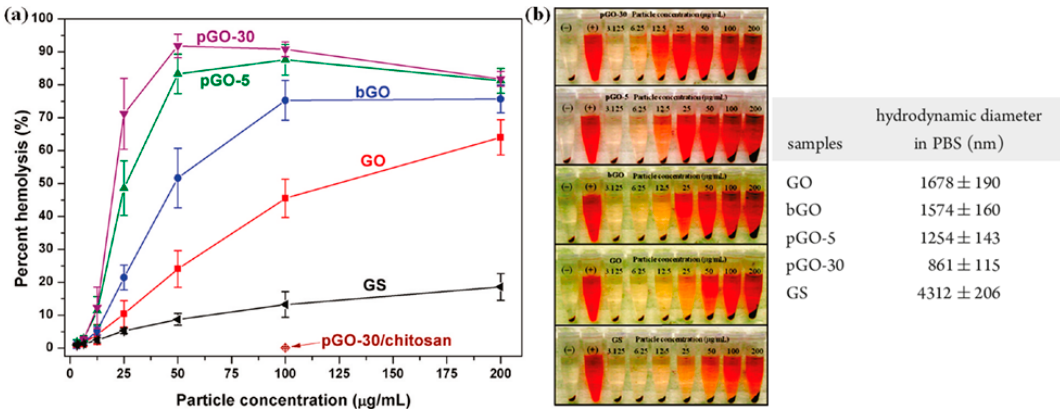
Figure 12. ( a ) Percent hemolysis of RBCs incubated with different concentrations of graphite oxide colloidal suspension obtained from Hummers’ method (GO) and smaller graphene oxide obtained with sonication or hydrothermal processing (bGO, pGO-5, pGO-30, and GS). ( b ) Photographs of RBCs after exposure to the different GO samples, with red hemoglobin in the supernatant indicating the presence of RBCs with membrane damage. The hemolysis rate was dose- and size-dependent. Adapted with permission from [213]. Copyright 2011 American Chemical Society.